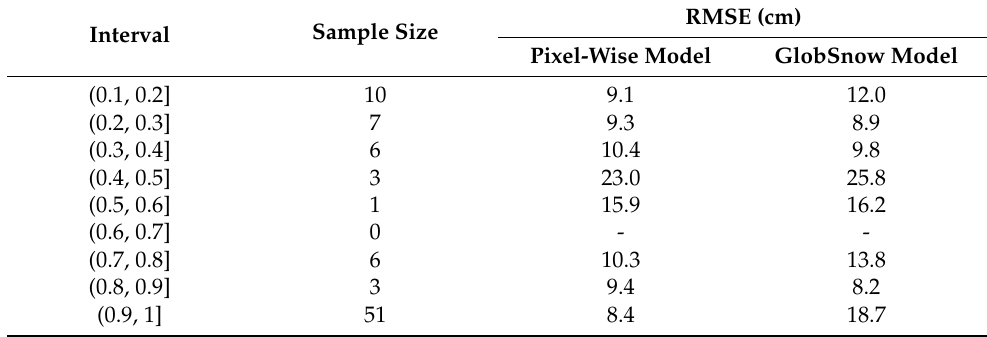
Table 4. Summary of pixel SD verification results in each forest coverage rate